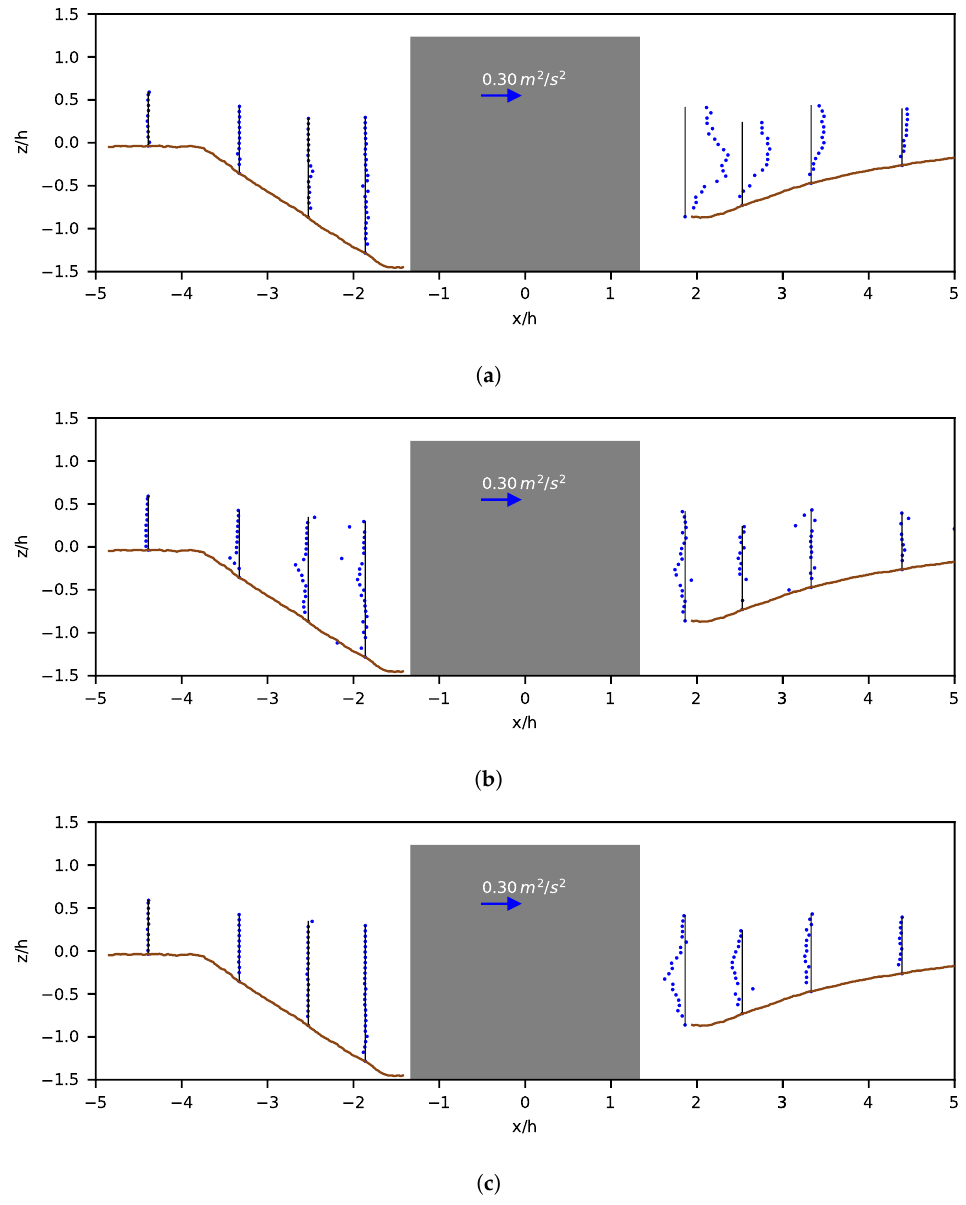
Figure 16. Vertical profiles of the Reynolds shear stresses along the pier’s mid-plane for Exp . 1 U Ebed . ( a ) Reynolds shear stresses ( u (cid:48) v (cid:48) ). ( b ) Reynolds shear stresses ( u (cid:48) w (cid:48) ). ( c ) Reynolds shear stresses ( v (cid:48) w (cid:48)